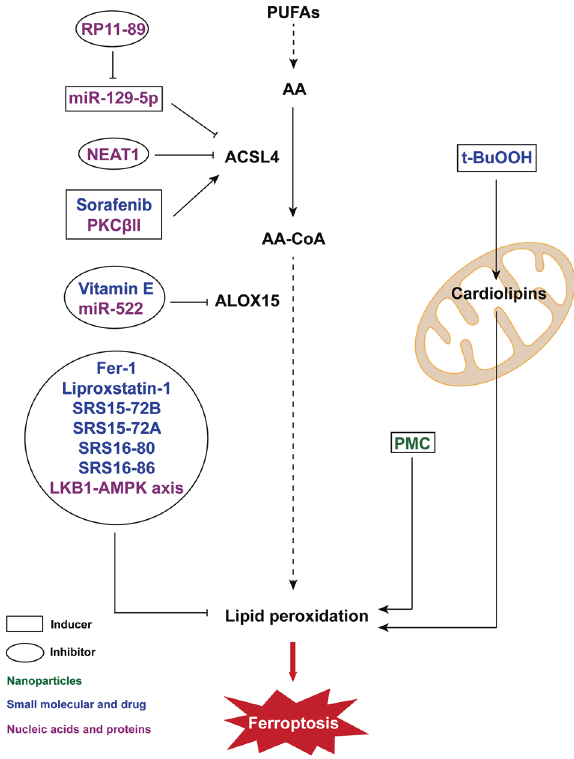
Fig. 2 Substances that affect ferroptosis by regulating lipid metabolism. Lipid ROS accumulation caused by lipid peroxidation plays an important role in ferroptosis while antioxidants can prevent ferroptosis. Two of the important enzymes in lipid metabolism are ACSL4 and ALOX15, thus their regulators affect the process of ferroptosis. NEAT1 nuclear enriched transcript 1, Fer-1 ferrostatin-1, ACSL4 acyl-CoA synthetase long chain family member 4, ALOX15 arachidonate lipoxygenase 15, PUFAs polyunsaturated fatty acids, AA arachidonic acid, AA-CoA acyl-CoA, PMC photosynthetic